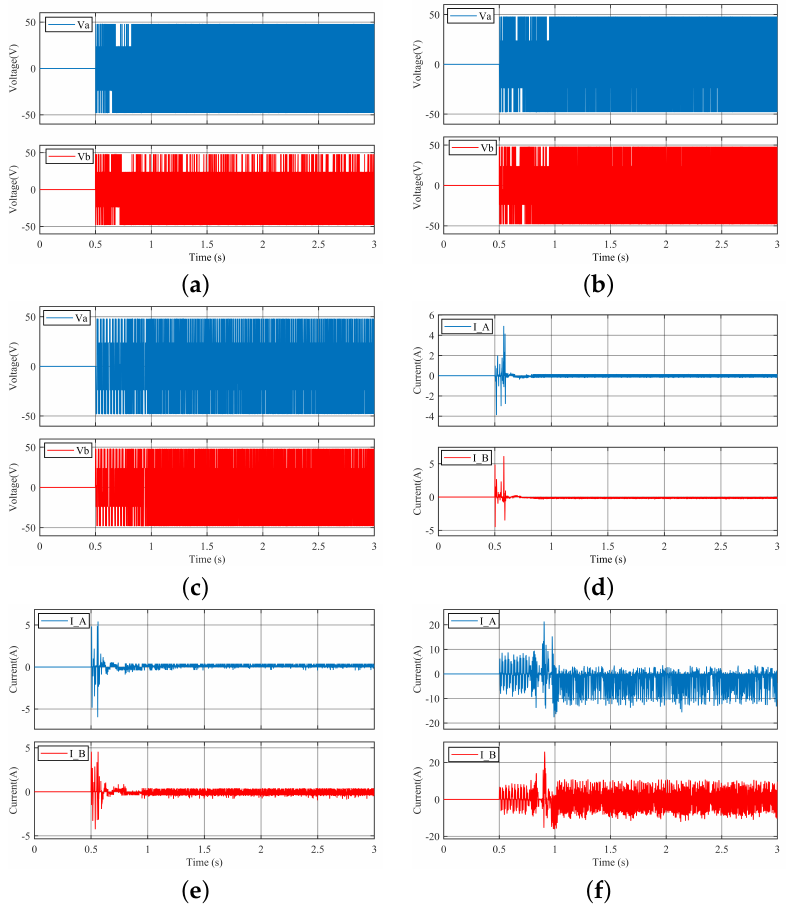
Figure 11. The actuation signals for the step response of different controllers. ( a ) The actuation voltage of the ADRC controller; ( b )The actuation voltage of the PID controller; ( c ) The actuation voltage of the SMC controller; ( d ) The actuation current of the ADRC controller; ( e ) The actuation current of the PID controller; ( f ) The actuation current of the SMC